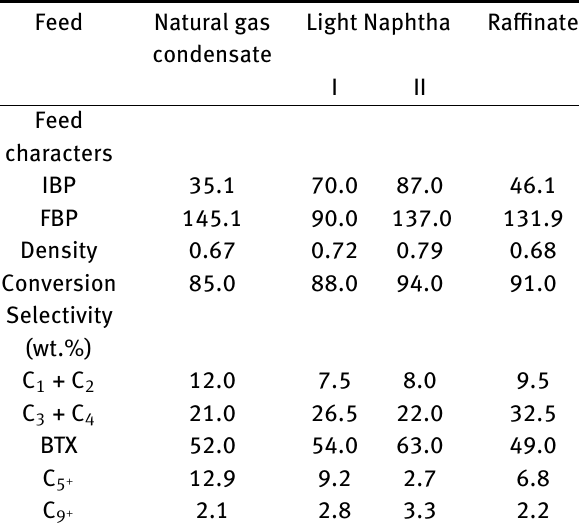
Table 8: Feed characteristics and product selectivities over Zn-Al-Si catalyst [56]